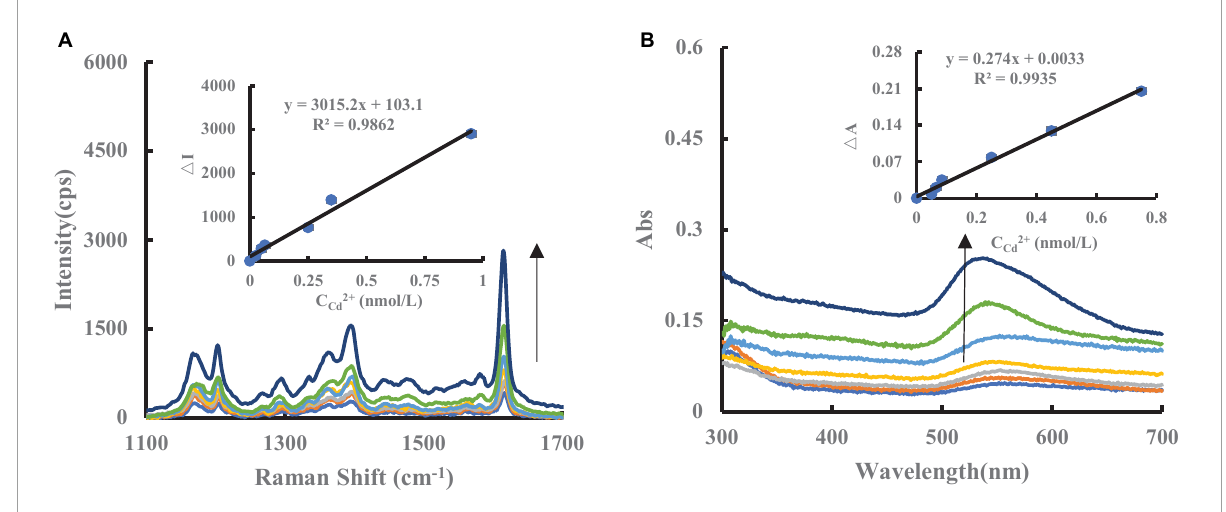
FIGURE4 SERS/Abs spectra of catalytic amplification system. (A) (0, 0.025, 0.050, 0.065, 0.25, 0.35, 0.95) nmol/L Cd 2 + + 5 nmol/L PT + 6.25 µ g/mL